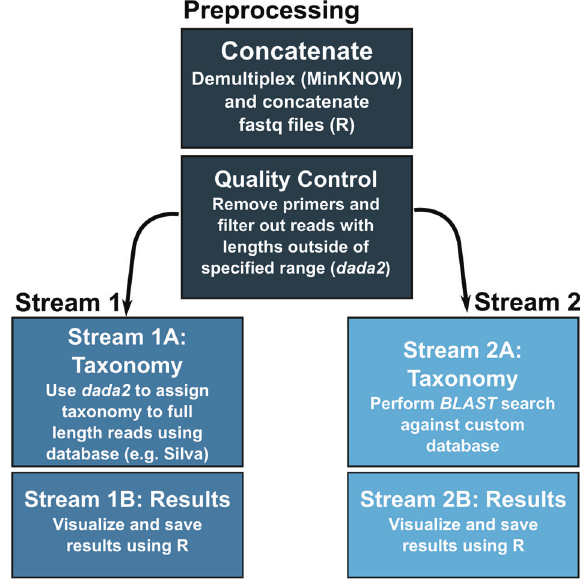
Fig. 2 SituSeq bioinformatics work fl ow. The preprocessing script contains quality control steps that remove primers and fi lter sequences outside the speci fi ed length parameters. The Stream 1 work fl ow uses the assignTaxonomy function from dada2 to assign taxonomy to all Nanopore sequences. The Stream 2 work fl ow performs a BLASTn search of the Nanopore sequences as queries against a custom